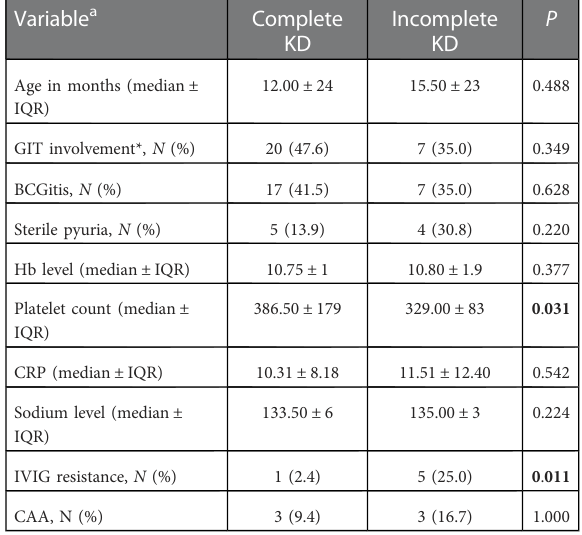
TABLE 1 Frequency of clinical manifestations in KD patients. Clinical Manifestation